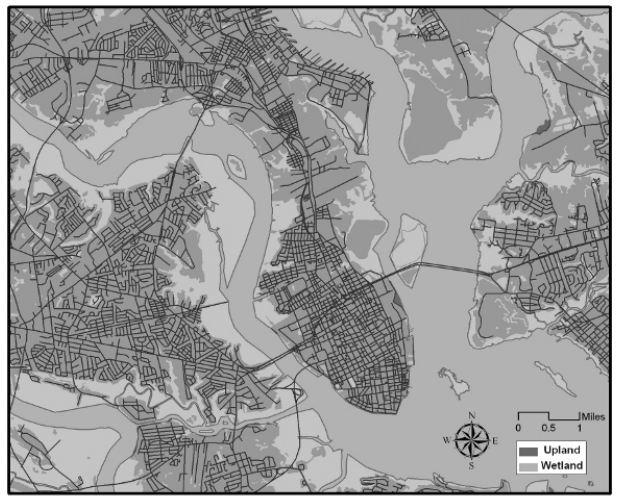
Fig. 1. The Charleston peninsula and surrounding areas showing the extent of road development and wetlands (Sources: South Carolina Department of Natural Resources 2005, U.S. Fish and Wildlife Service